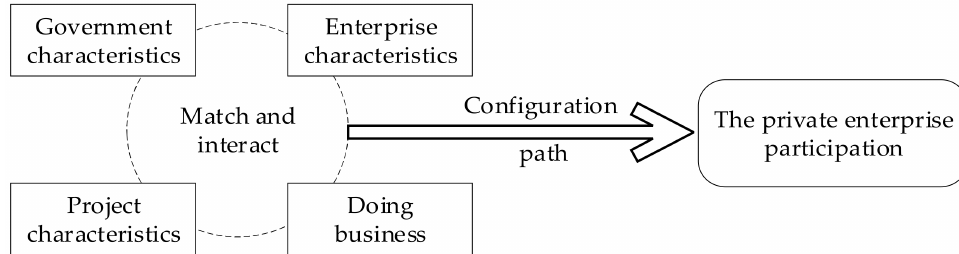
Figure 1. Theoretical model